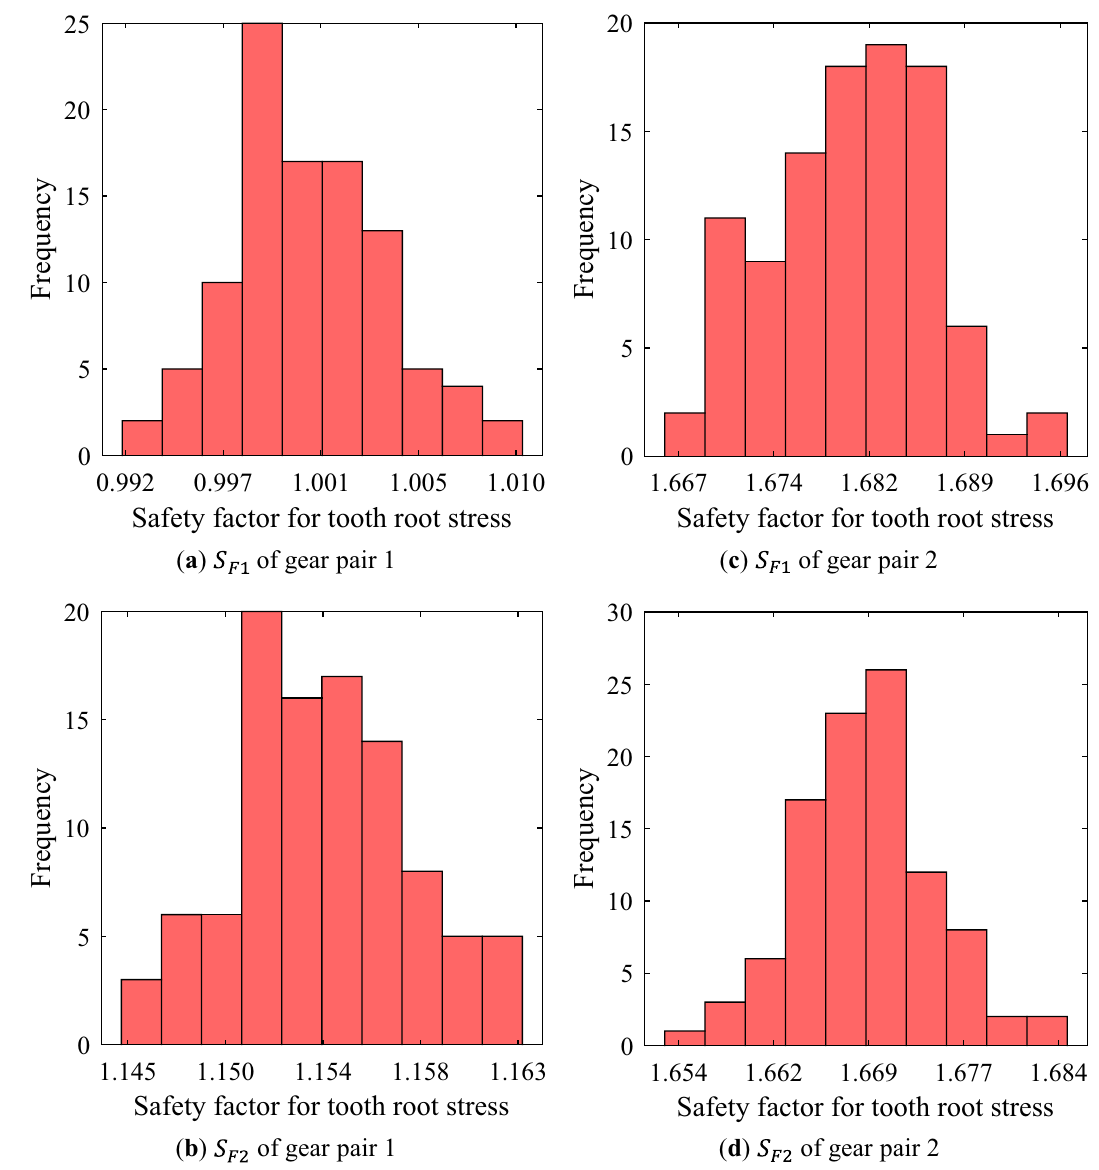
Figure 2. Frequency distribution of safety factor for tooth root stress of pinion and wheel of each gear pair using random robustness